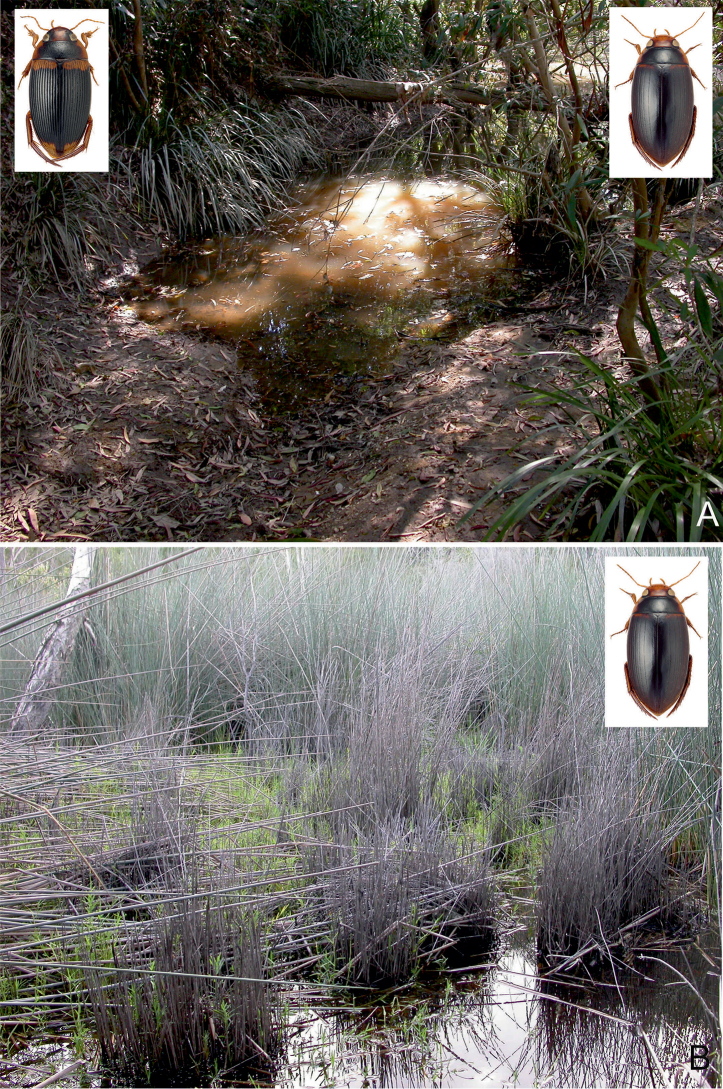
Habitat of Copelatus
irregularis and C.
clarkiA residual pool of the stream bed of Oakly Creek, Queensland (Loc. 28) B only of C.
clarki, Stradbroke Island, temporary sedge swamp near Brown Lake, Queensland. Photographs by L. Hendrich.